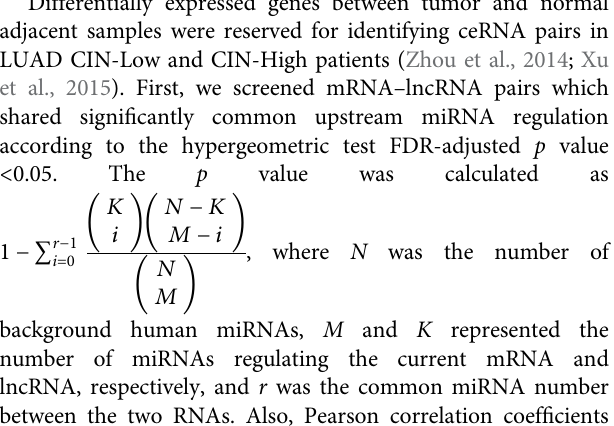
Frontiers in Molecular Biosciences |